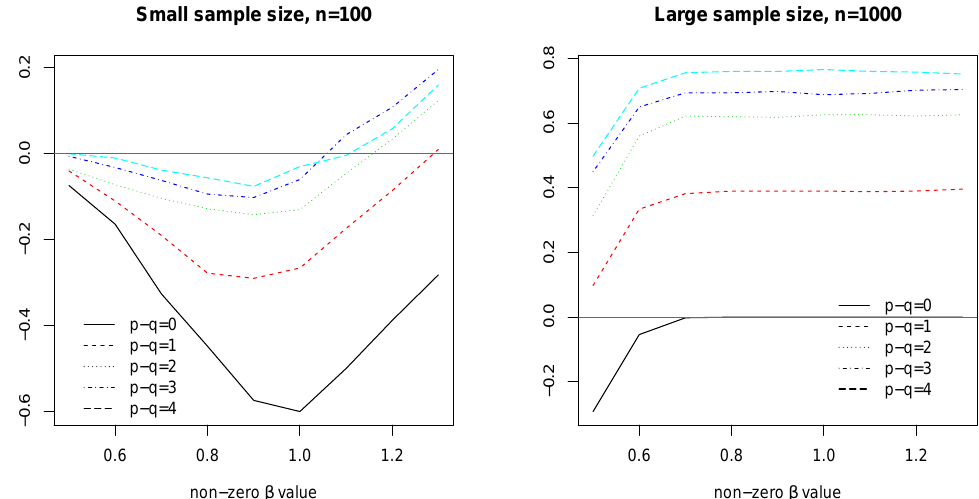
Figure 3. Difference in proportions of selecting true model: P c ( λ 1 se ) − P c ( λ min ) (positive means 1se is